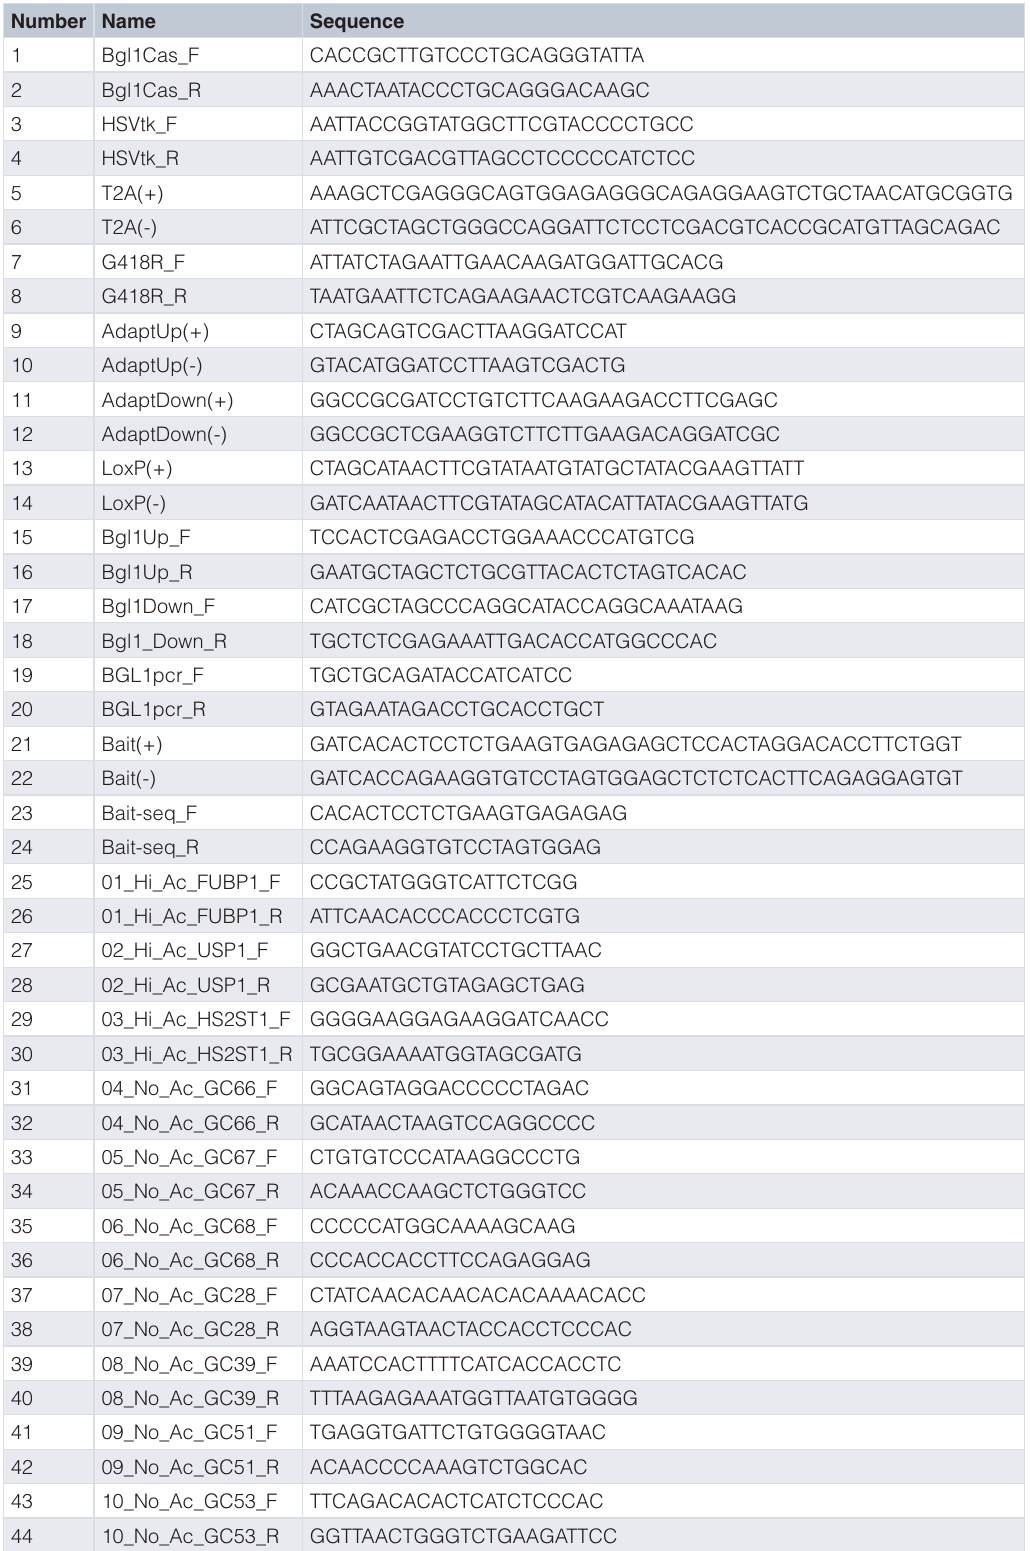
Table 2. Oligonucleotides used in this